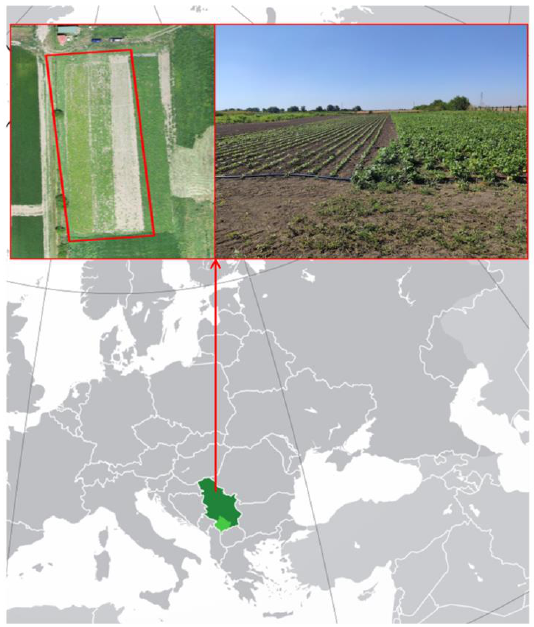
Figure 1. Location of study area.